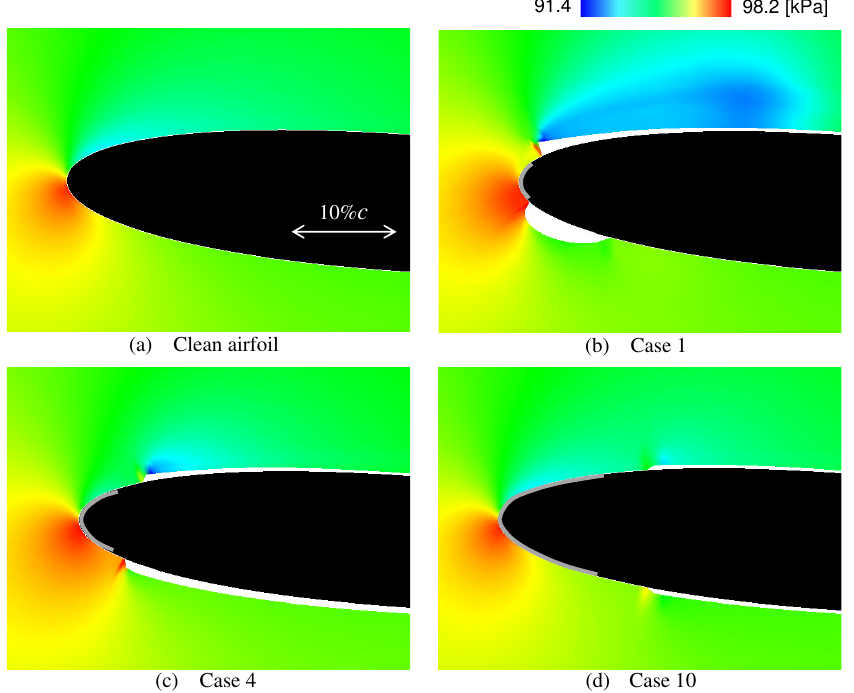
Figure 10. Static pressure distribution and icing shapes around the NACA 0012. The white and dark gray regions on the airfoil surface indicate the location of the formed ice and heater, respectively: ( a ) Clean airfoil without icing; ( b ) Case 1; ( c ) Case 4; and, ( d ) Case 10.